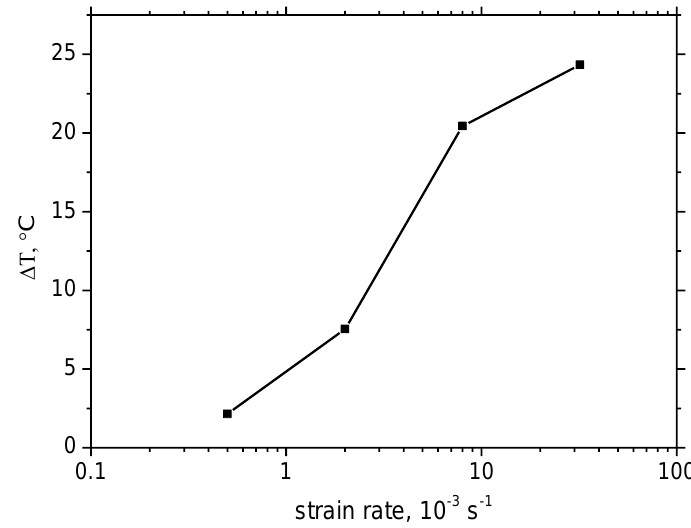
∆ T as a function of strain rate at plastic strain 32.5%. Figure 5.  T as a function of strain rate at plastic strain 32.5%. Figure 5.